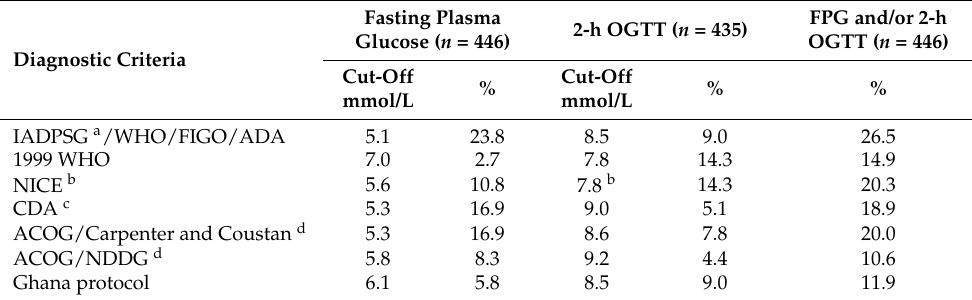
Table 1. Prevalence of GDM according to some commonly used diagnostic